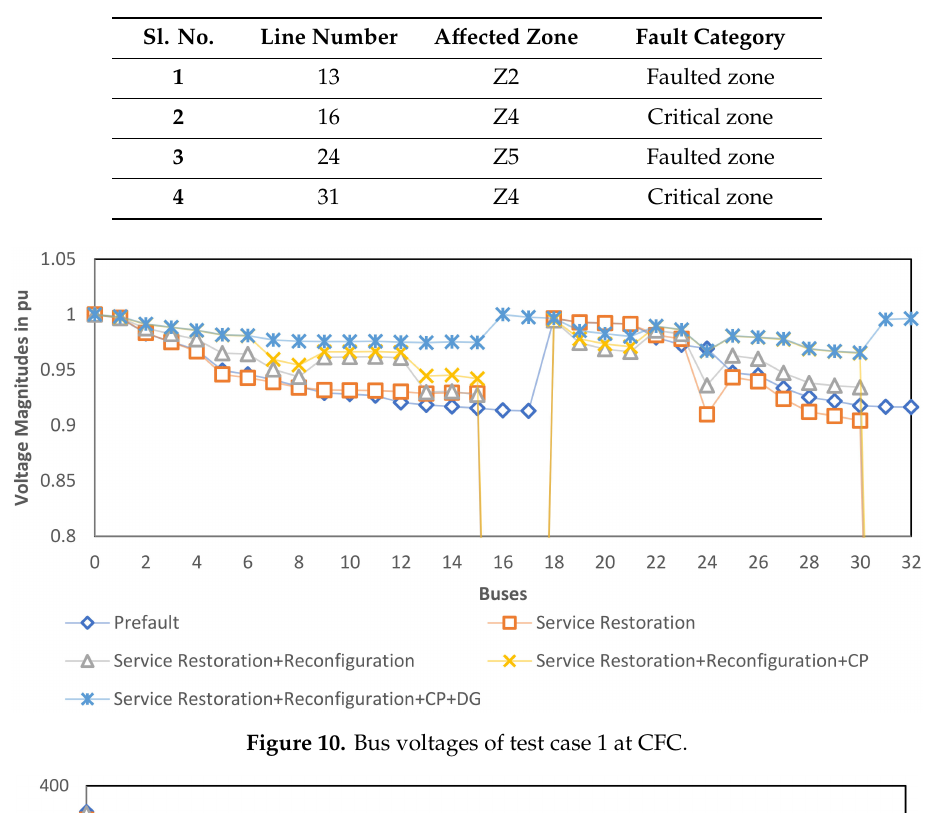
Table 5. Assumed faulted lines of test case 1.